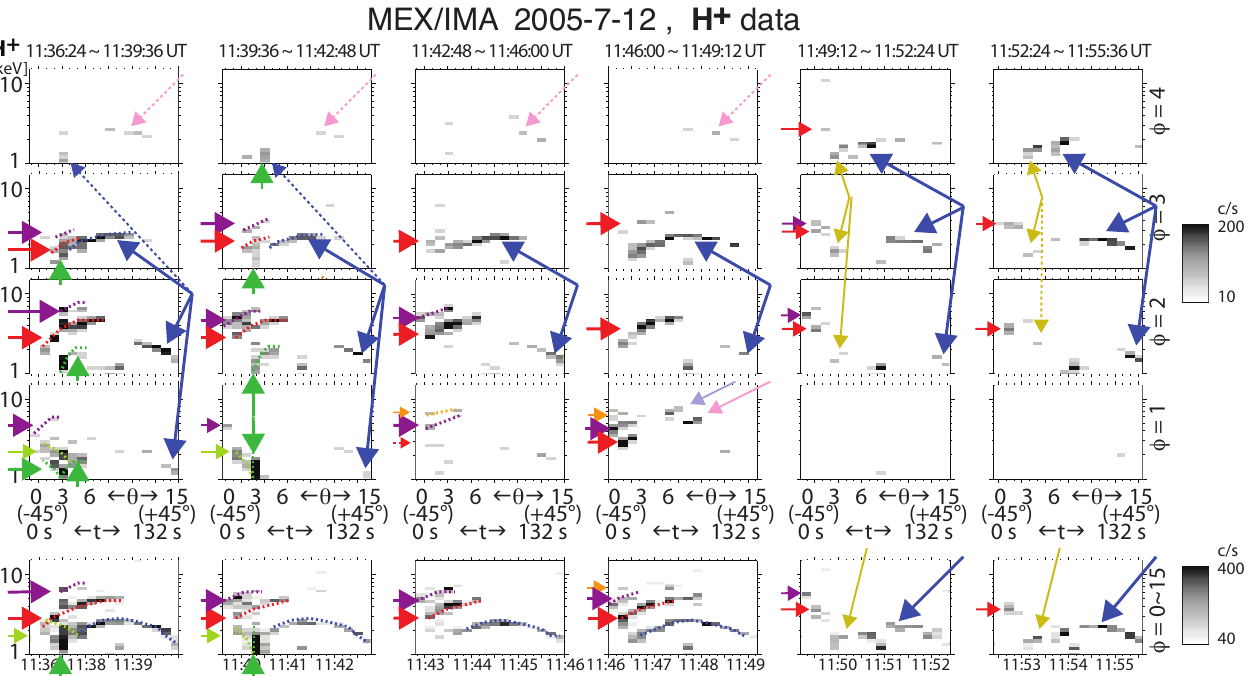
Fig. 7. Energy-time spectrograms from MEX/IMA proton channels (1 ∼ 15keV per charge) on 12 July 2005 during 11:36:24 ∼ 11:55:36UT (part of Fig. 6) in a similar format as Fig. 4. Four different azimuthal sectors (from top, φ = 4, 3, 2, 1) and integration over all φ are presented. sector 0 is not presented because it gathers contamination from all of the other sectors. The first pixels of each spectrogram correspond to − 45 ◦ elevation ( θ = 0) and the last pixels to + 45 ◦ elevation ( θ = 15). Contamination from solar wind alpha particles is seen at about 1.5keV per charge (i.e., 3keV with q = 2) at 0 ◦ elevation ( θ = 8). Otherwise, the ion species (proton) is confirmed by the energy-mass matrix (not shown here). Arrows with the same color indicate the same ion population and arrows with different colors indicate different ion populations. The same colors are used in Fig. 8, i.e., blue is the primary ring distribution, and red, purple, and orange are accelerated ions.